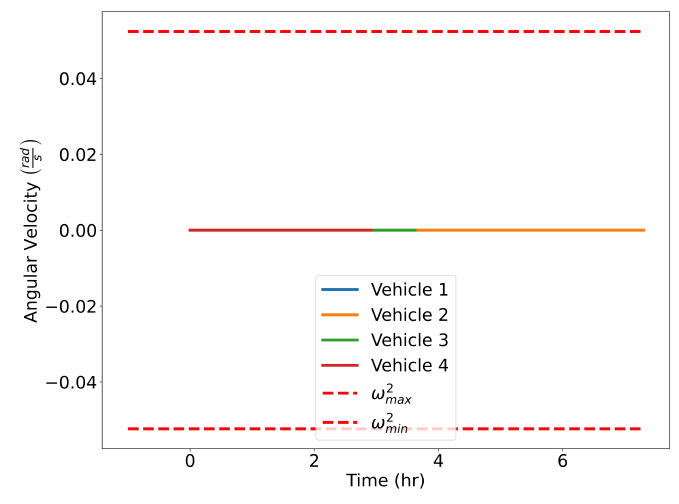
Figure 28. Verifying angular rate constraints for the Air Traffic Control example.